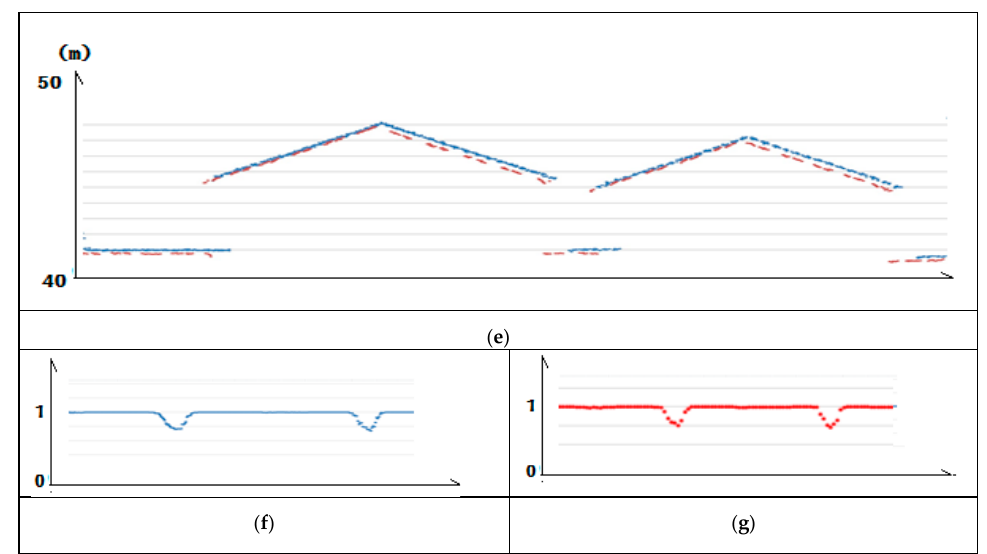
Figure 2. ( a ) Aerial images and section line PQ ; ( b ) height image; ( c ) C s image; ( d ) green color: trees and grass (HVC), blue color: roof ridge and step (HVC), and brown color: inclined planes, plate planes, and plate ground (SVC); ( e ) Z-values (height values) on the section line PQ . The di ff erent colors denote di ff erent Lidar strips; ( f ) and ( g ): C s values on section line PQ . The C s values were derived from the TVM.